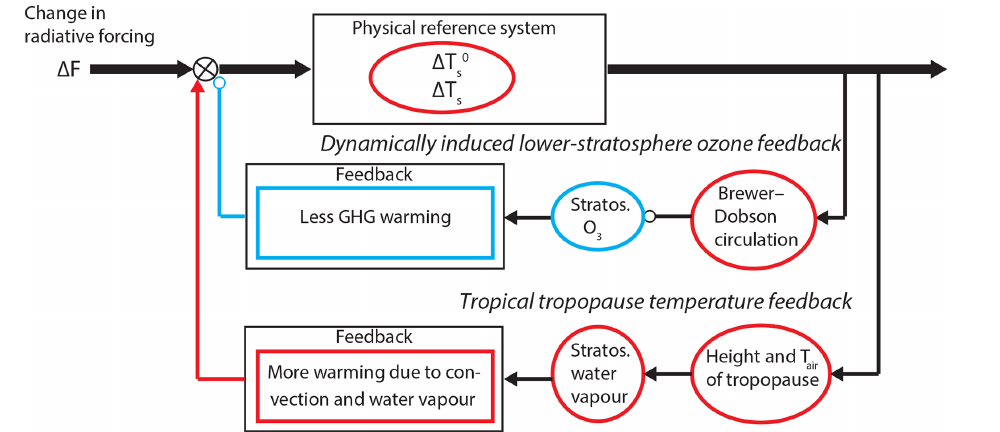
Figure 16. Schematic of important stratospheric chemistry feedbacks. Arrows indicate positive coupling; open circles indicate negative coupling. Changes in state variables are indicated by ellipses. Red indicates increasing values of variables, strengthening of processes, or positive feedbacks; blue indicates the opposite. The change in surface air temperature (cid:49)T s in the presence of feedback is different from the change (cid:49)T 0 s without